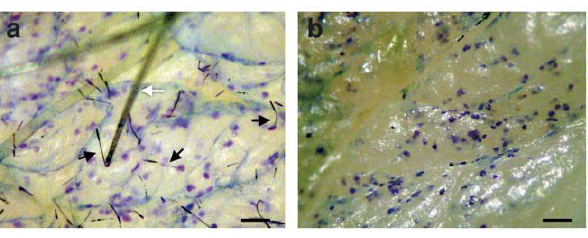
Figure 3. In-vitro delivery of hydrophilic compounds by cnidocysts in a gel formulation. (a) Activation of cnidocyst gel over isolated porcine ear skin with 0.05% toluidine blue dye solution for 5 min. Following application the skin was thoroughly washed and then photographed. Black arrows, penetrating cnidocyst. White arrow, skin hair bundle. Scale bar, 100 m m. (b) The skin was tape-stripped 30 times to remove the stratum corneum and then photographed. Scale bar, 100 m